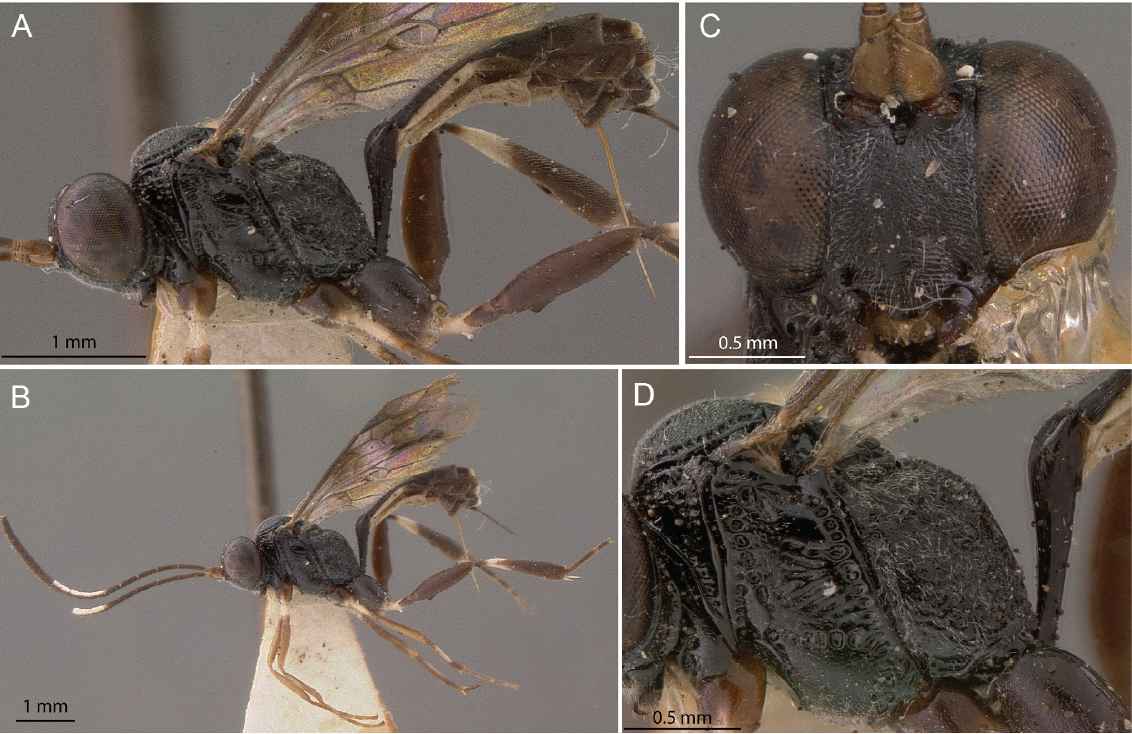
Fig. 24. Palpostilpnus papuator (Aubert, 1961), holotype, ♀ (USUC). A . Lateral habitus. B . Lateral habitus. C . Head, anterior view. D .